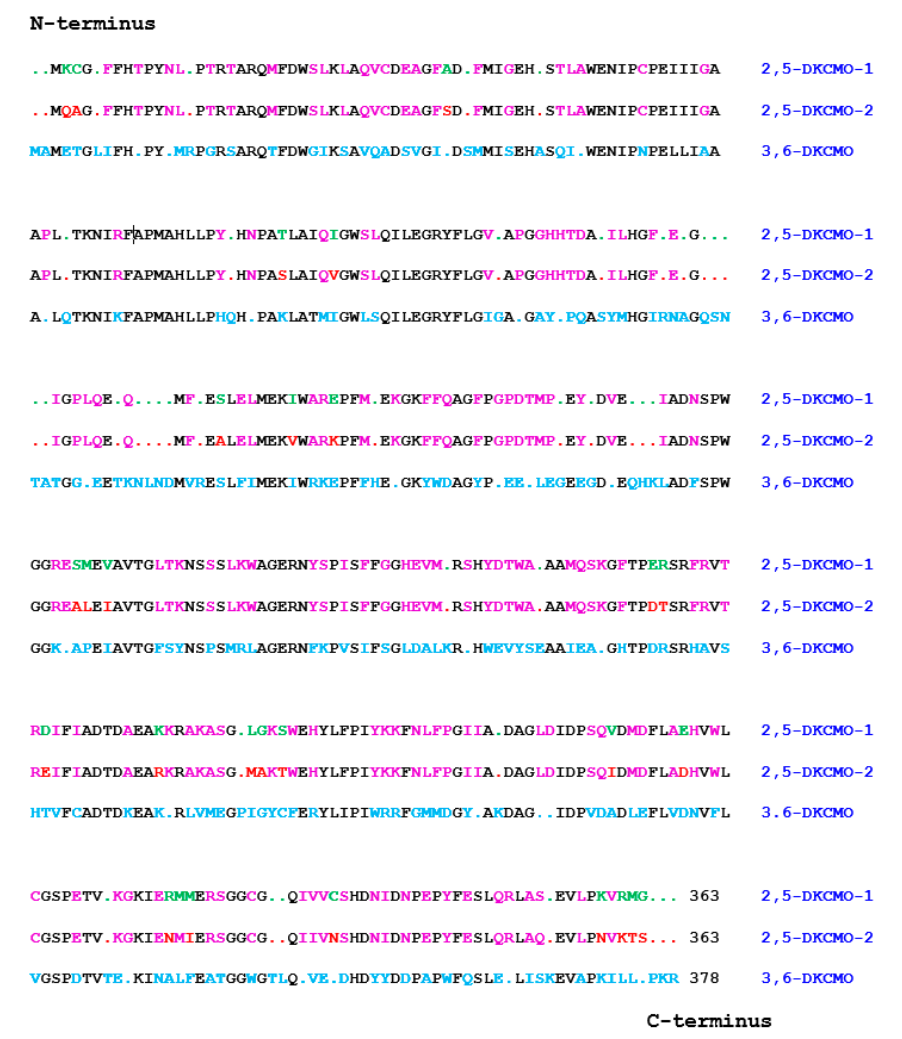
Figure 9. Protein sequence alignment of the oxygenating subunits of 2,5-DKCMO-1 ( orf-4 , camE 25-1 ), 2,5-DKCMO-2 ( orf-22 , camE 25-2 ) and 3,6-DKCMO ( orf-19 , camE 36 ). Amino acid residues: common to 2,5-DKCMO-1, 2,5-DKCMO-2, and 3,6-DKCMO = black; common to 2,5-DKCMO-1 and 2,5-DKCMO-2 = purple; exclusive to 2,5-DKCMO-1 = green; exclusive to 2,5-DKCMO-2 = red; exclusive to 3,6-DKCMO = blue.